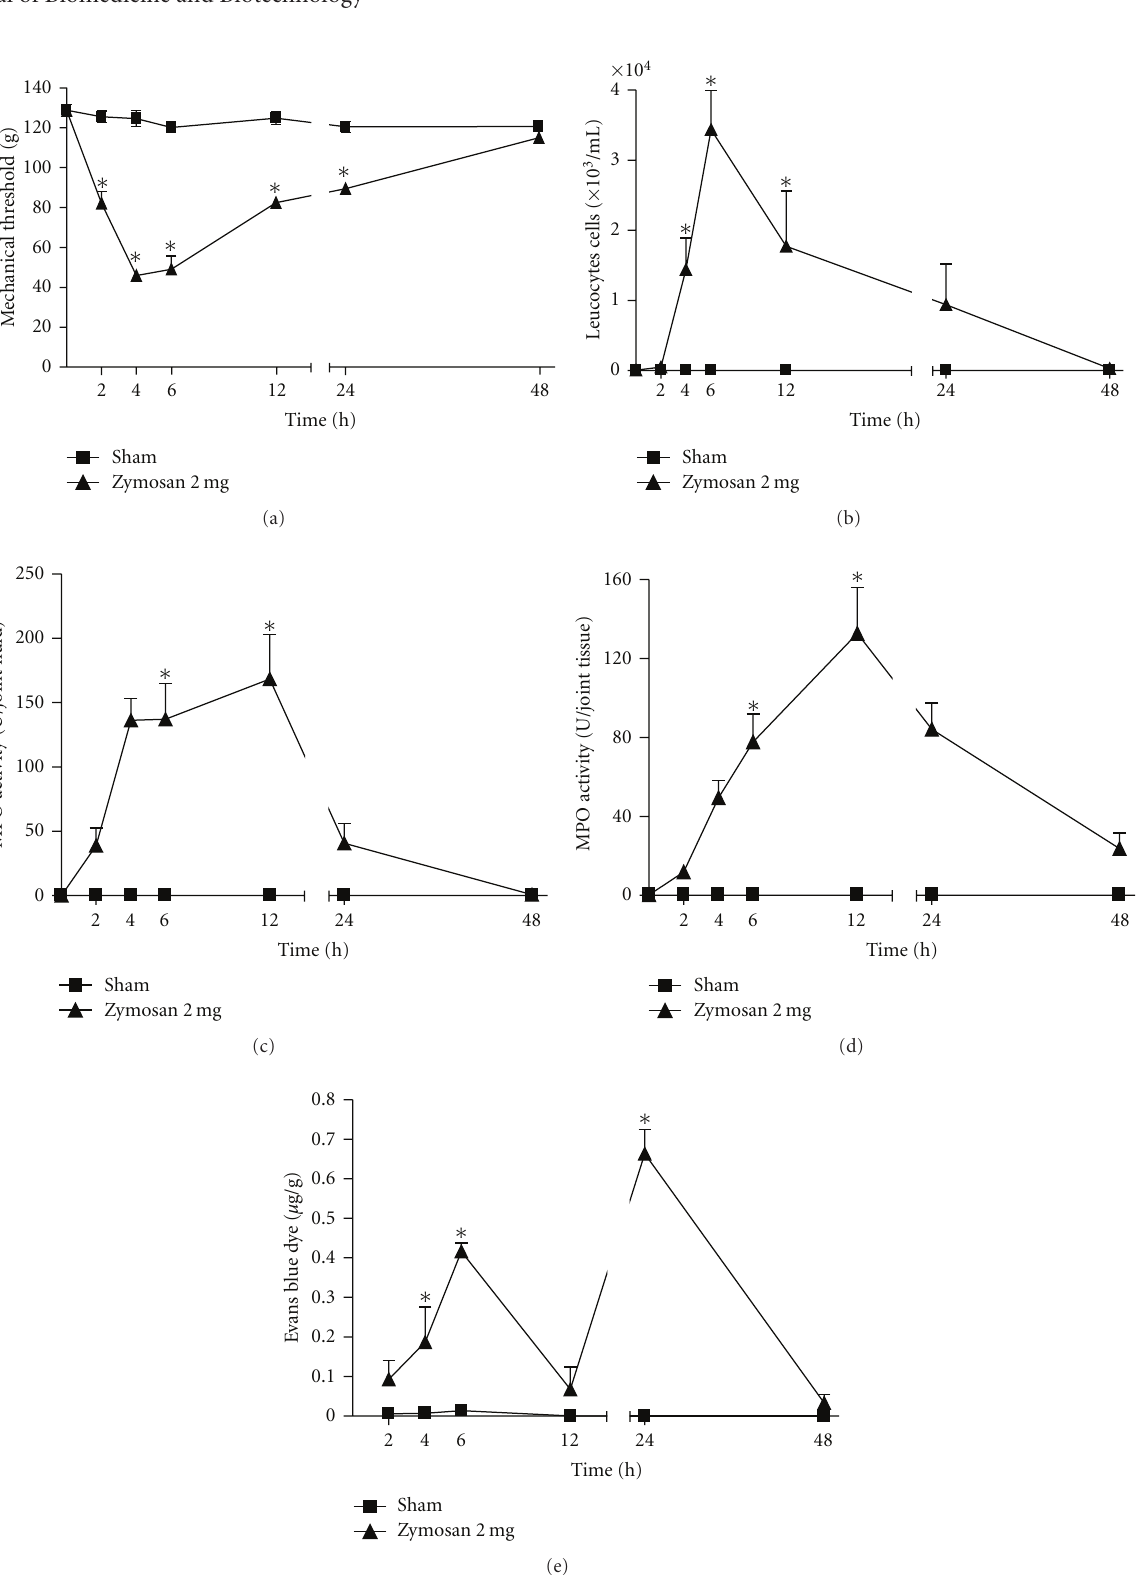
Figure 2: Temporal profile (0–48h) of the inflammatory and hypernociceptive e ff ects of zymosan-induced TMJ arthritis. Zymosan (2mg; 40 μ L) or saline was injected i.art. into the left TMJ of the rat. The mechanical nociceptive threshold was measured before and after an i.art. injection of zymosan or saline until the 48th hour (a). Leukocyte migration was evaluated by cell counting in TMJ fluid (b). MPO activity from TMJ fluid (c) and TMJ tissues (d). Plasma extravasation (PE) following an i.art. injection of zymosan or saline (e). Data are expressed as means ± SEM ( n = 6). ∗ P < . 05 versus Sham (ANOVA,